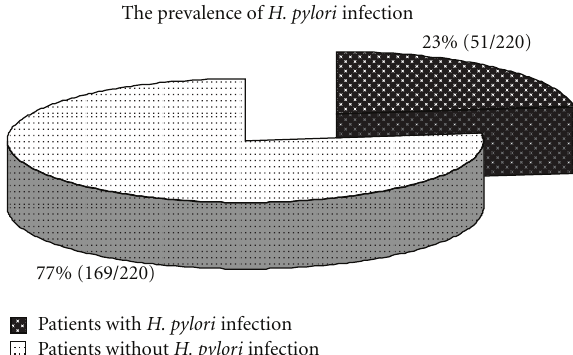
Figure 1: The prevalence of H. pylori infection among dyspeptic patients enrolled in the study in